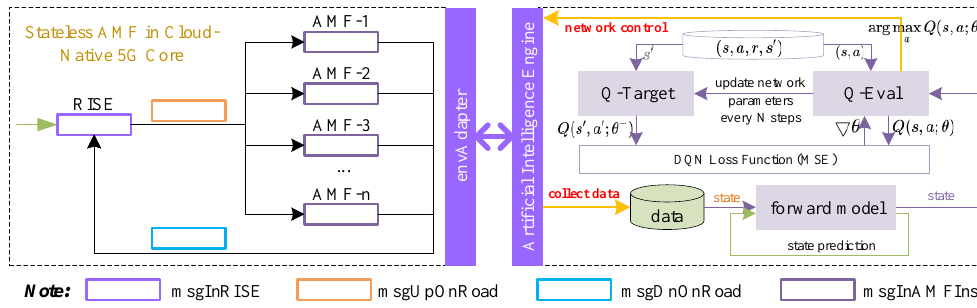
Figure 5. Architecture: Delayed-DQN-enabled AMF